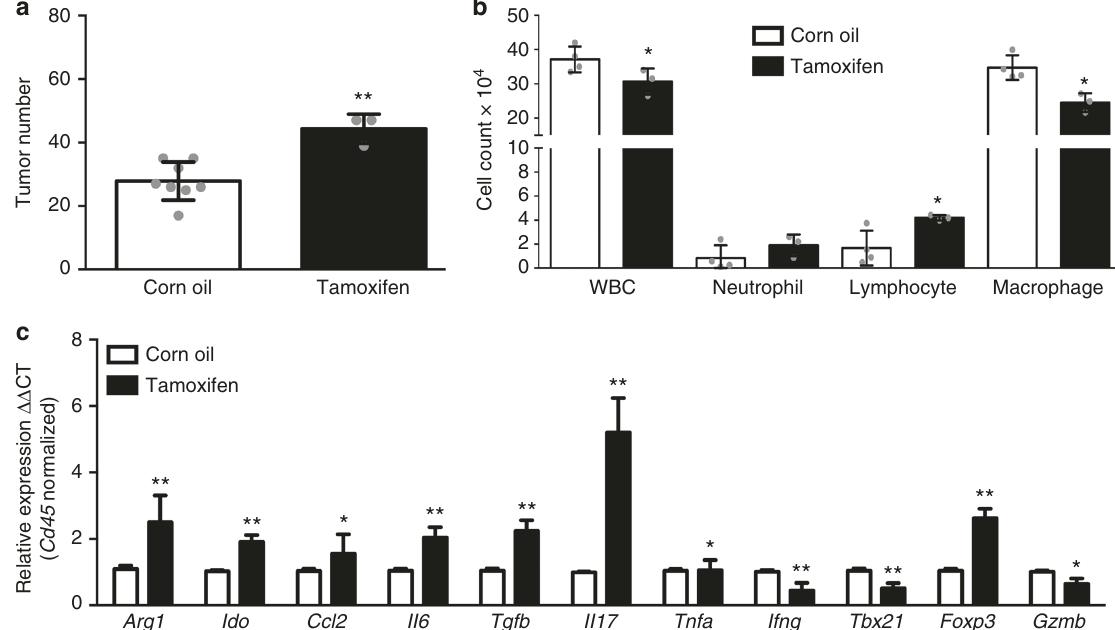
Fig. 6 Estrogen receptor blockade promotes lung tumorigenesis in female LR/ Stat3 Δ / Δ mice. a Lung surface tumor number in 14-week-old female LR/ Stat3 Δ / Δ mice after corn oil ( n = 8) or tamoxifen ( n = 3) treatment. b Total in fl ammatory cell and lineage-speci fi c leukocyte numbers from BALF of female LR/ Stat3 Δ / Δ mice after corn oil ( n = 4) or tamoxifen ( n = 3) treatment. c Relative expression of Arg1 , Ido , Ccl2 , Il6 , Tgfb , Il17 , Tnfa , Ifng , Tbx21 , Foxp3 , and Gzmb mRNA in whole lungs, normalized by CD45 expression, of female LR/ Stat3 Δ / Δ mice after corn oil ( n = 4) or tamoxifen ( n = 3) treatment (data represent means± SEM; ** P < 0.005, * P < 0.05 using two-tailed t -test, experimental replicate #